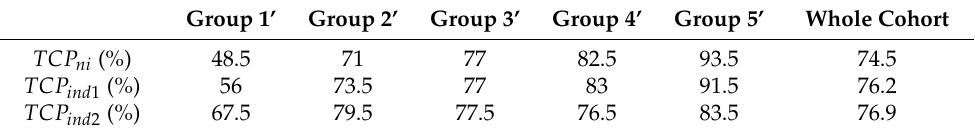
Table 3. Overall and group-specific tumor control probability when the injected activity is not adapted to each group ( TCP ni ), and when it is adapted according to Strategy 2 with ∆ A = 0.1 ∗ A 0 ( TCP ind 1 ) or ∆ A = 0.2 ∗ A 0 ( TCP ind 2 ). The stratification in groups is performed according to radiosensitivity of the tumor, characterized by parameter b (see Figure 2), and activities administered to each group are A 0 + ∆ A (Group 1’), A 0 + ∆ A /2 (Group 2’), A 0 (Group 3’), A 0 − ∆ A /2 (Group 4’), A 0 − ∆ A (Group 5’).